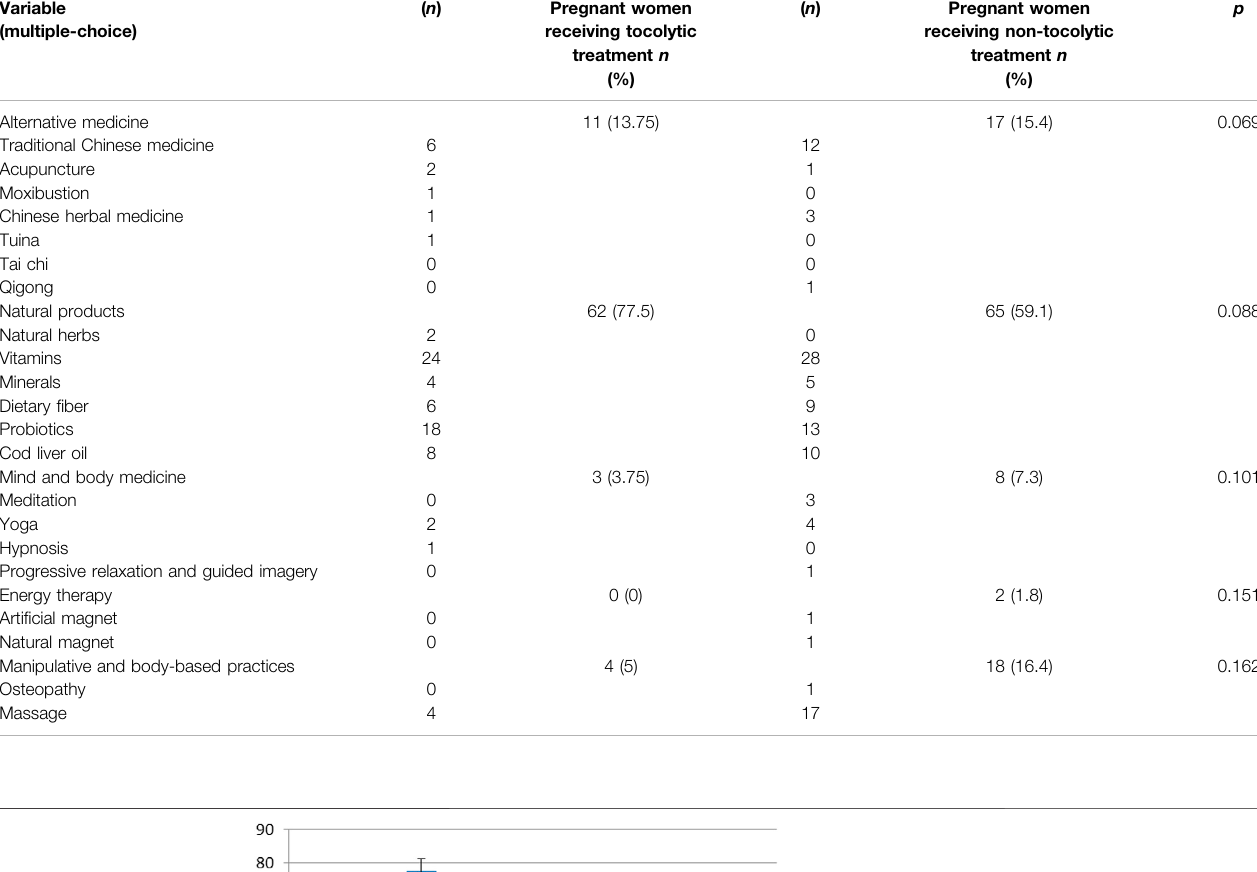
TABLE 2 | Analysis of the types of complementary medicine used by pregnant women receiving tocolytic and non-tocolytic treatment ( n = 70). Variable (multiple-choice)